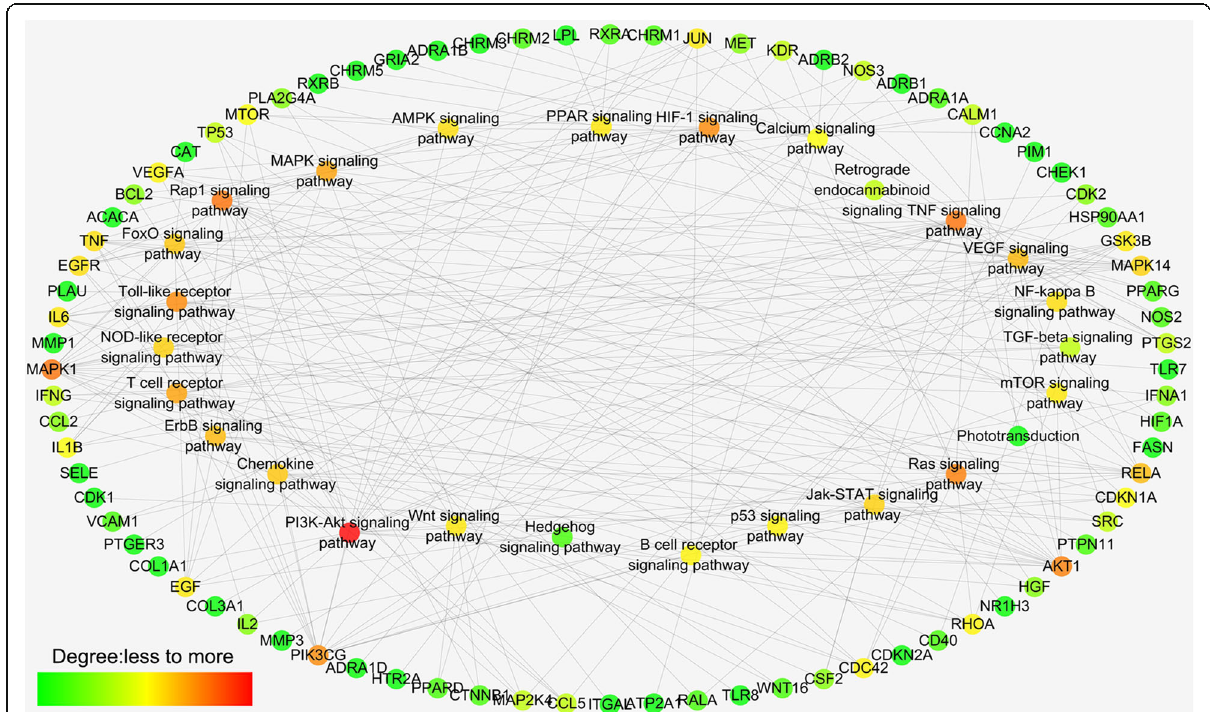
Fig. 6 Target – pathway network. Network of 26 signaling pathways (rectangle nodes) connected to 80 target genes (circular